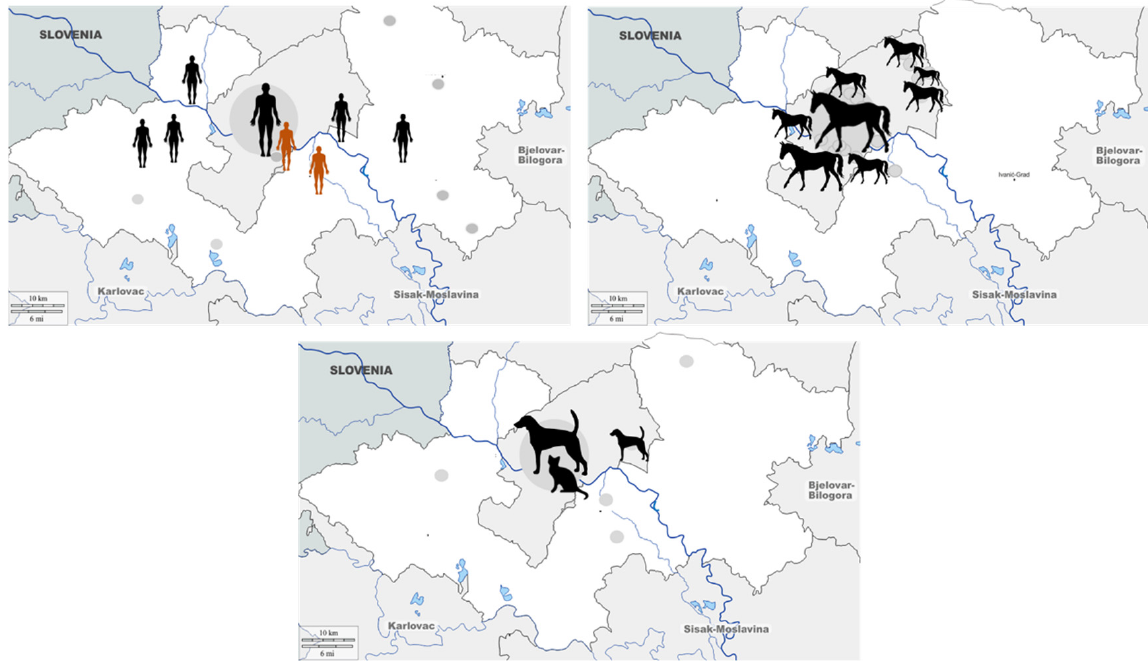
Figure 4. Tahyna virus-neutralizing antibody titers in humans and animals. A total of 4456 Ae. vexans mosquitoes were collected and identified in the Zagreb area, of which 4053/90.9% mosquitoes were sampled by traps with CO 2 , while 403/9.1% were sampled by the aspirator. Mosquito specimens were sorted in 159 pools and tested for the presence of TAHV (Table 5). All tested pools were negative for TAHV.